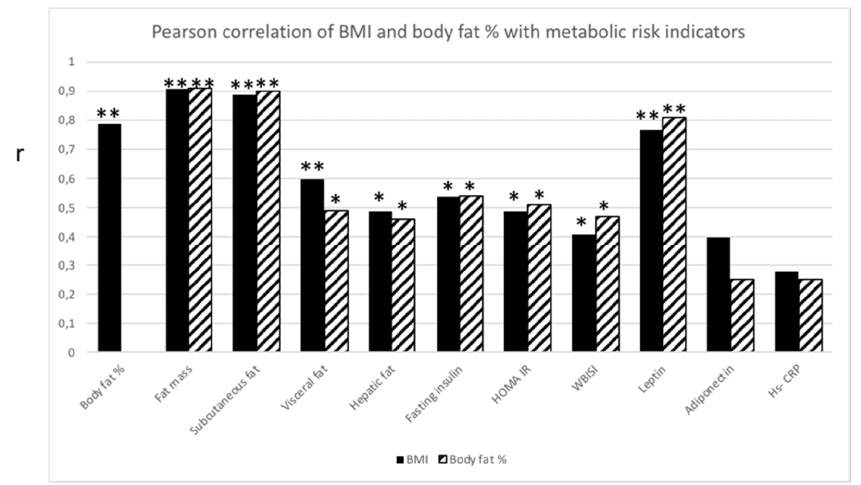
Figure 1. Pearson correlation analysis between BMI (black bar) and body fat % (striped bar), respectively, and metabolic risk indicators. Significant correlation (r) between BMI or body fat % with metabolic risk indicators. * p ≤ 0.05; ** p ≤ 0.01.